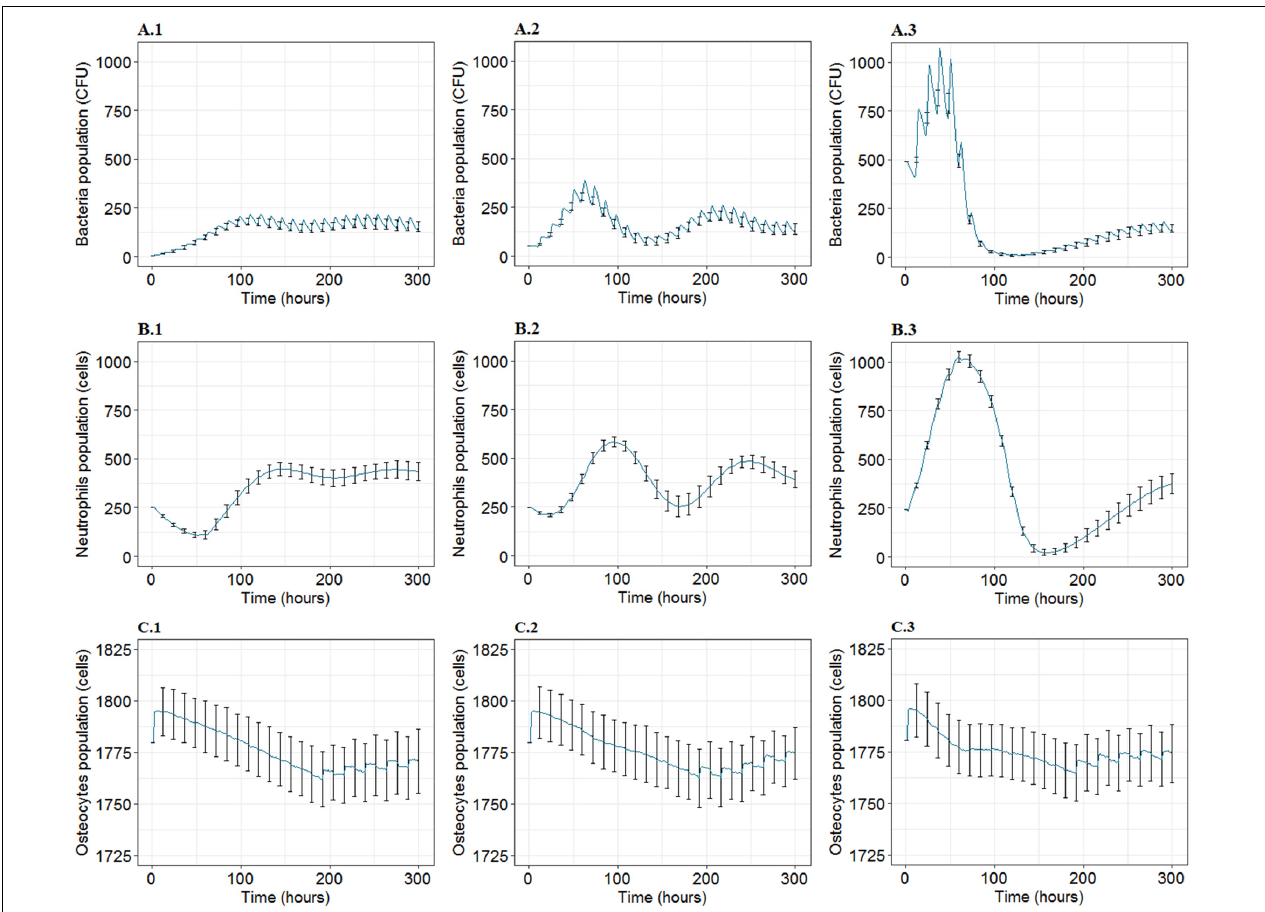
FIGURE 3 | The mean and standard deviation (SD) for 100 iterations for agent populations over time, t = 300 h, at three inoculum infection states of bacteria (5, 50, 500 CFU/mm 2 ). (A1–A3) Show the mean and SD of the bacteria population over time. (B1–B3) Show the mean and SD corresponding to neutrophils population. (C1–C3) Represent mean and SD for osteocytes population. First, second and third columns represent the results for inoculum infection states of low (5 CFU/mm 2 ), medium (5 × 10 CFU/mm 2 ), and high (5 × 10 2 CFU/mm 2 ) bacteria